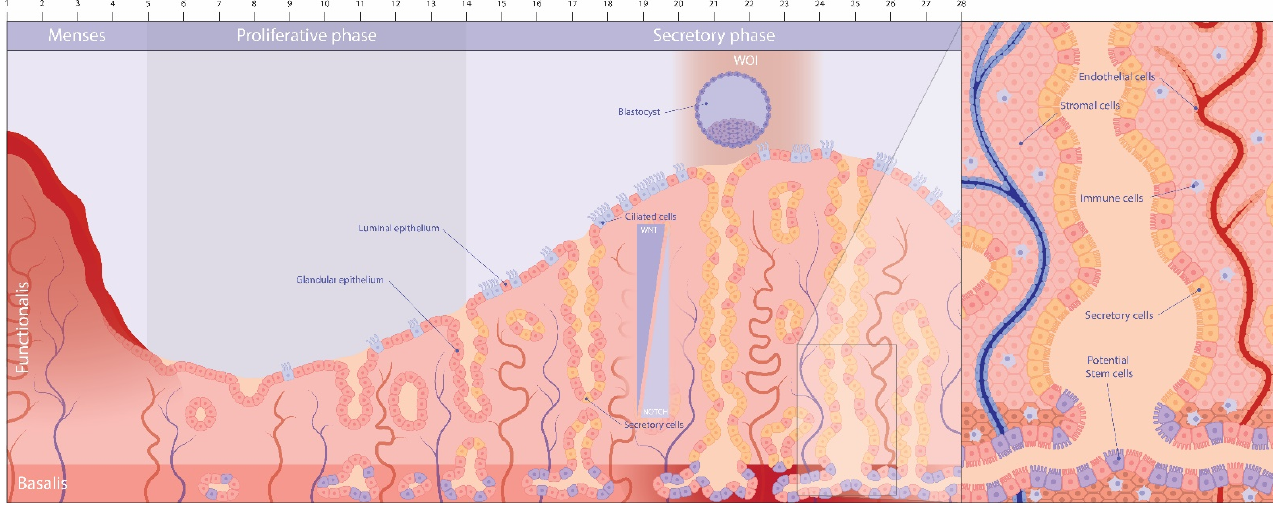
Figure 1. The endometrium during the menstrual cycle.